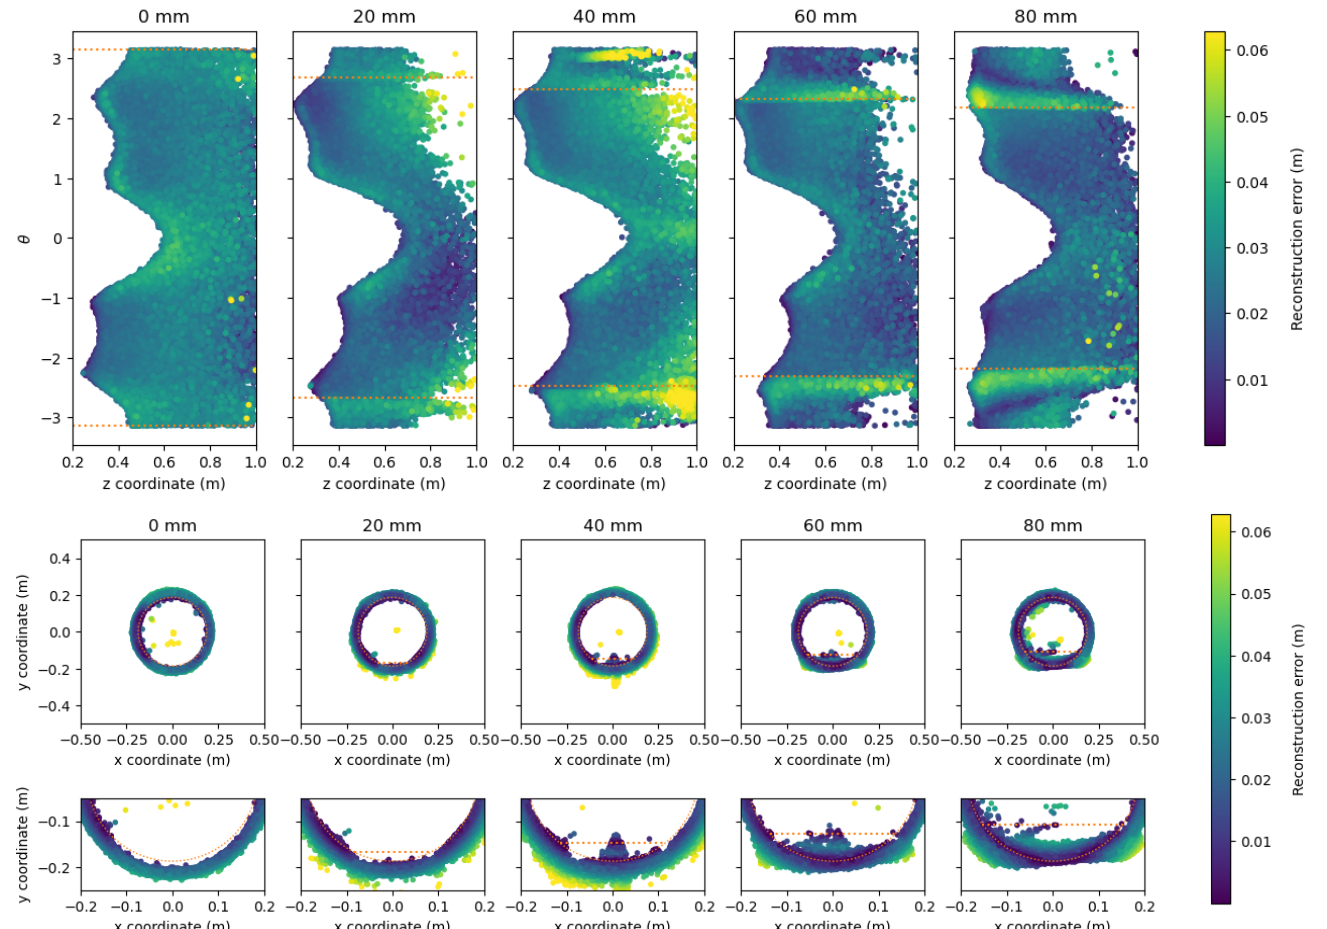
Figure 17. Reconstructed point cloud for the water level experiments by the pico flexx camera. The water level and pipe geometry is indicated with the orange line. The points are color-coded according to the cloud-to-mesh distance to the reference pipe. ( Top ) unfolded view of the reconstructed pipe. The water level is indicated with an orange dotted line. ( Middle ) View from the XY-plane of the reconstructed pipe. ( Bottom ) Zoomed in view of the XY-plane of the reconstructed